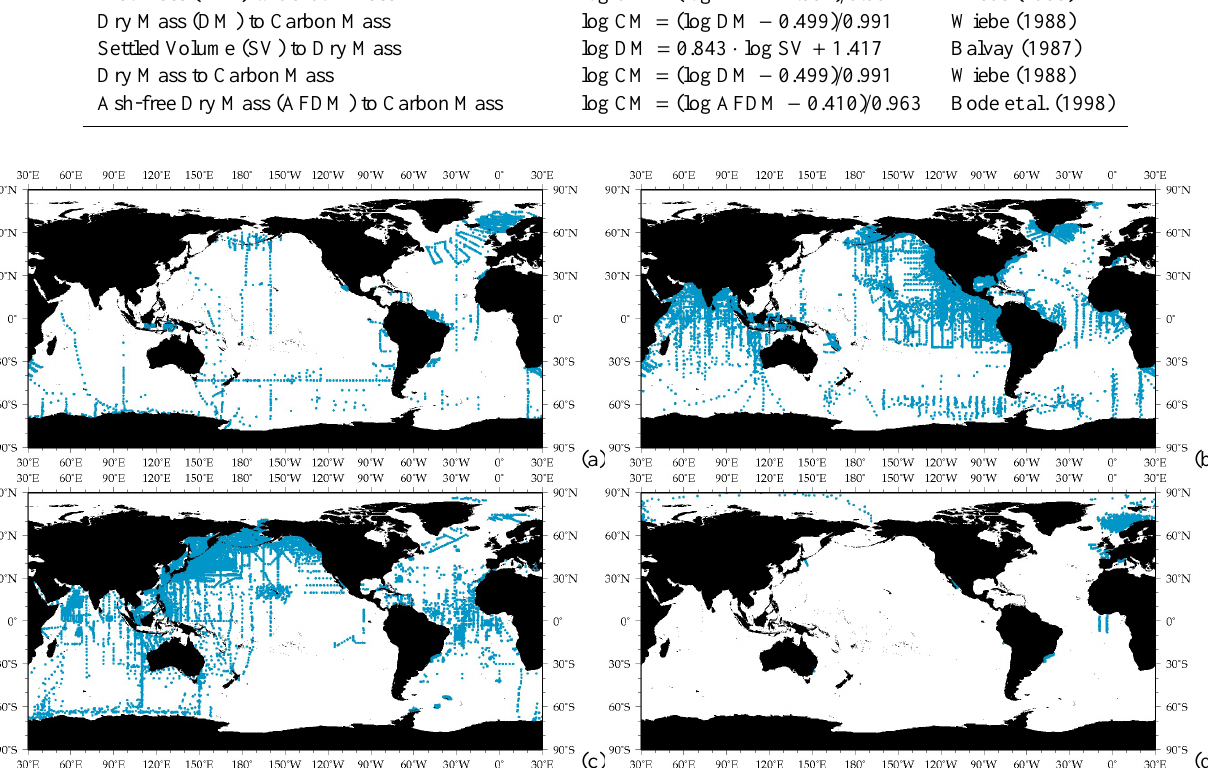
Figure 1. Distribution of the di ff erent types of biovolume and biomass samples: (a) settled volume, (b) displacement volume, (c) wet mass and (d) dry